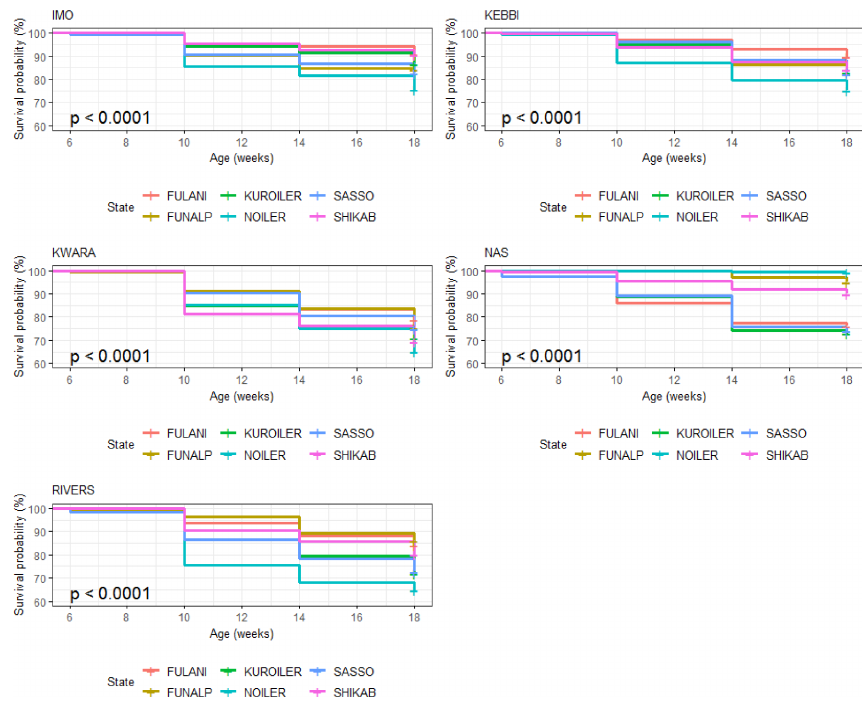
Figure 14. Breed by environment interaction on overall survivability of birds (agroecologies) during growing phase in ACGG Nigeria project zones (6–18 weeks) (2016–2017).